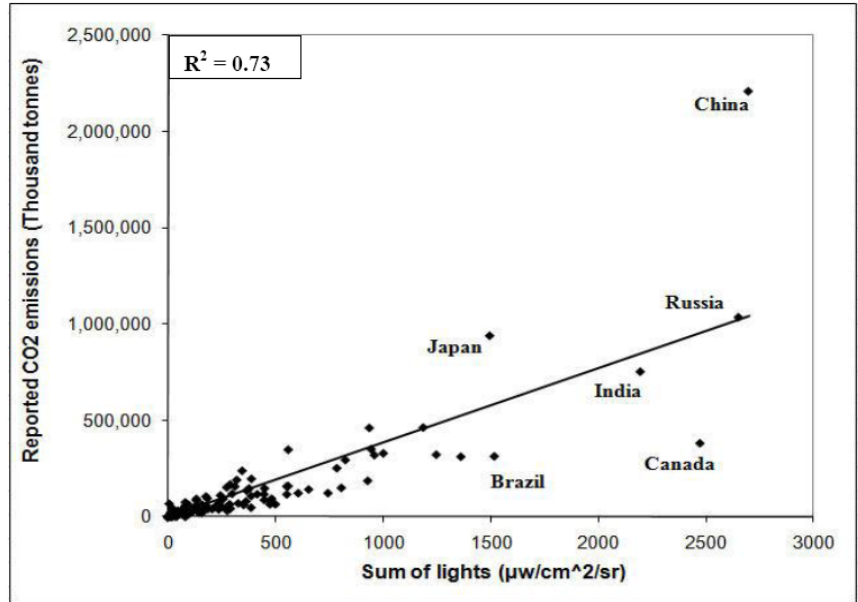
Figure 8. Regression relationship between sum of lights and reported non-utility CO emissions for all countries and states of the